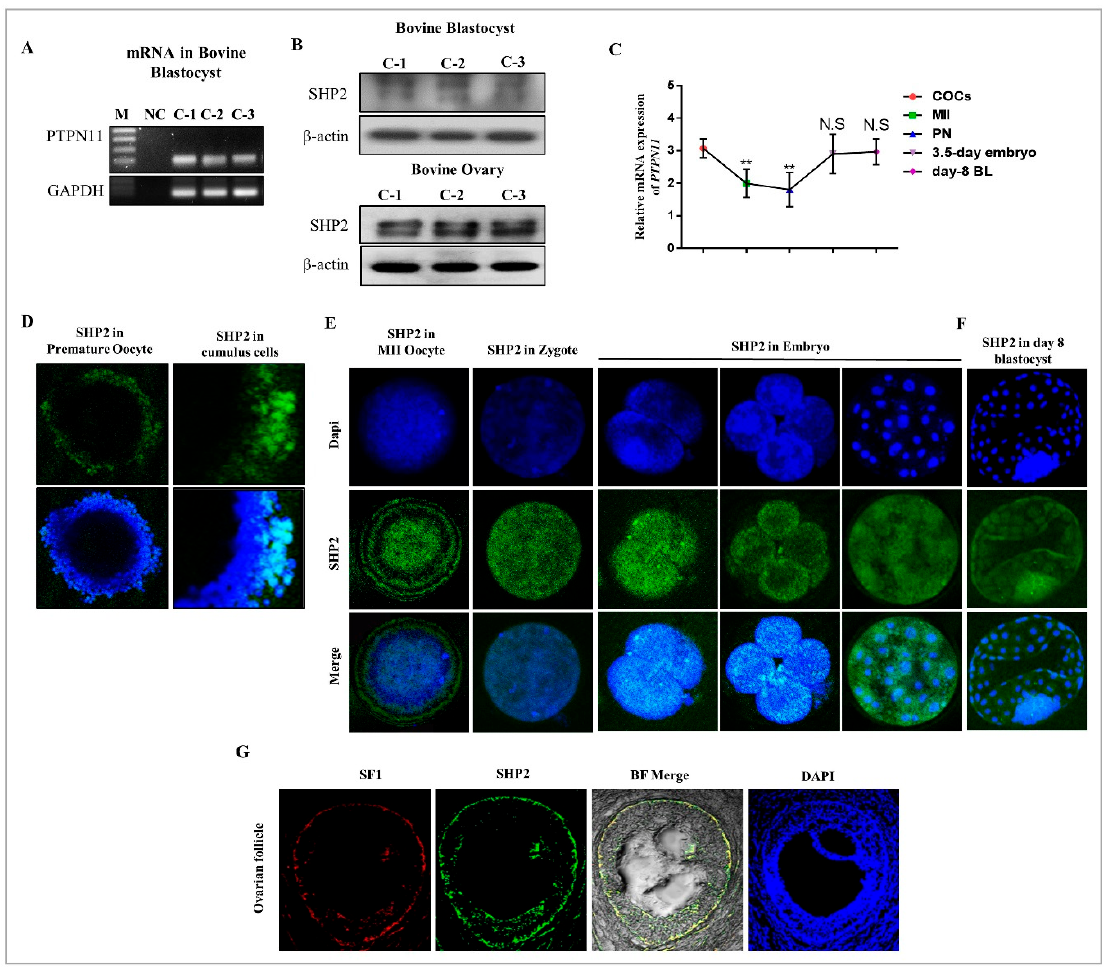
Figure 1. The qualitative expression of SHP2 in bovine oocytes, blastocysts and ovarian tissues. ( A ) PTPN11 mRNA expression was qualitatively analyzed in bovine day 8 blastocysts from three independent control groups with 100 bp (n = 5 per each group). GADPH was used as a housekeeping gene. ( B ) SHP2 protein expression was assessed via western blot from three independent control groups (C1, C2 and C3) in bovine day 8 blastocysts (n = 20) and ovaries (n = 3) at 90 kDa. β -actin was used as a loading control for western blot, and the experiments were repeated three times. ( C ) Quantitative real time RT-PCR analysis was performed for PTPN11 in GV oocyte (n = 20), MII oocyte (n = 20), Pronuclear zygote (PN) (n = 20), day 3.5 embryo (n = 5) and day 8 blastocyst (n = 5). ( D ) Representative image of immune labeling of SHP2 (green) in GV oocyte and cumulus cells from COCs (n = 20). ( E ) Immunoreactivity of SHP2 (green) in MII oocyte (n = 20), Zygote (n = 20), 2 cells (n = 20), 4 cells (n = 20) and day 3.5 embryo (n = 20). ( F ) SHP2 expression in bovine day 8 bovine blastocyst (n = 20). ( G ) Immunoflourscent co-localization of SF-1 (red) and SHP2 (green) in bovine pre-ovulatory follicle (n = 5). Image J was used to quantify the signal intensity of immunofluorescence images. All the experiments were repeated 3 times and the data are shown here as a mean ± S.E.M. * P < 0.05, ** P < 0.01 *** P < 0.001.